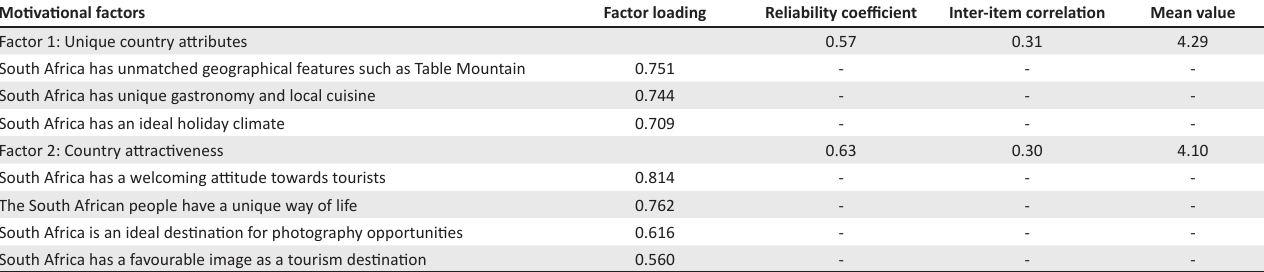
TABLE 2: Results of the factor analysis: Motives to travel to South Africa. Motivational factors